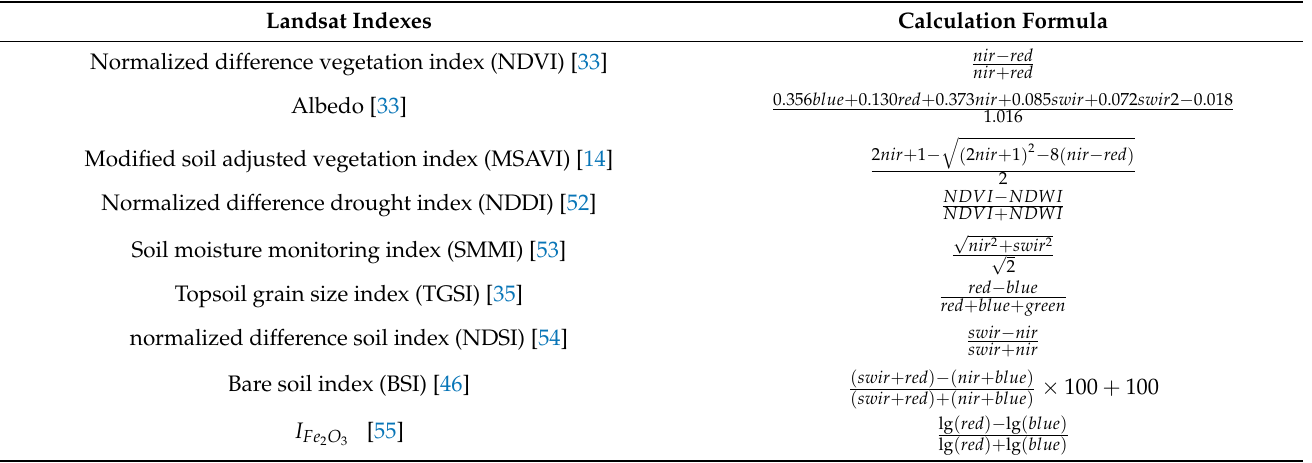
Table A3. Calculation formula of Landsat